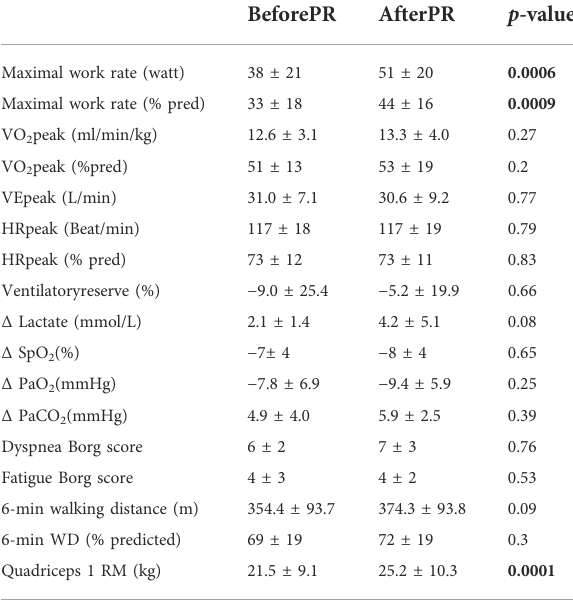
TABLE 1 Baseline characteristics and pulmonary function test results TABLE 2 Maximal functional capacity measured during incremental of the patients (mean ± SD). exercise test, walk test and quadriceps force assessment before and after pulmonary rehabilitation (PR) (mean ± Measured